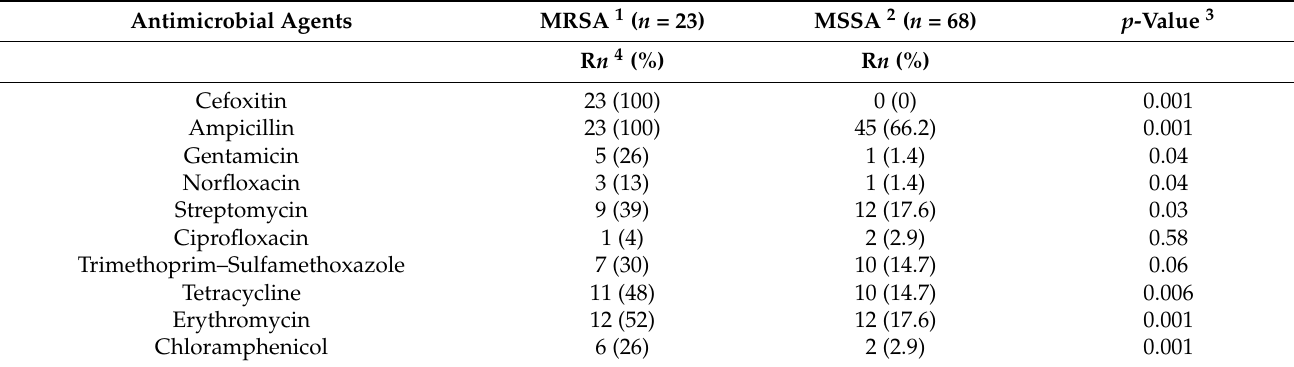
Table 2. Antimicrobial resistance pattern of MRSA and MSSA isolated from mastitic cows in two counties, Kenya ( n = 91). Antimicrobial Agents MRSA 1 ( n =